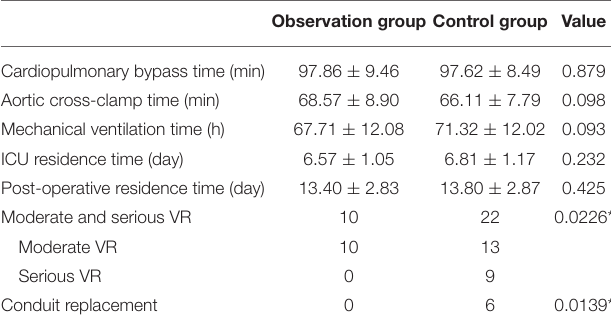
TABLE 2 | Post-operative and follow-up data from the two groups. Observation group Control group